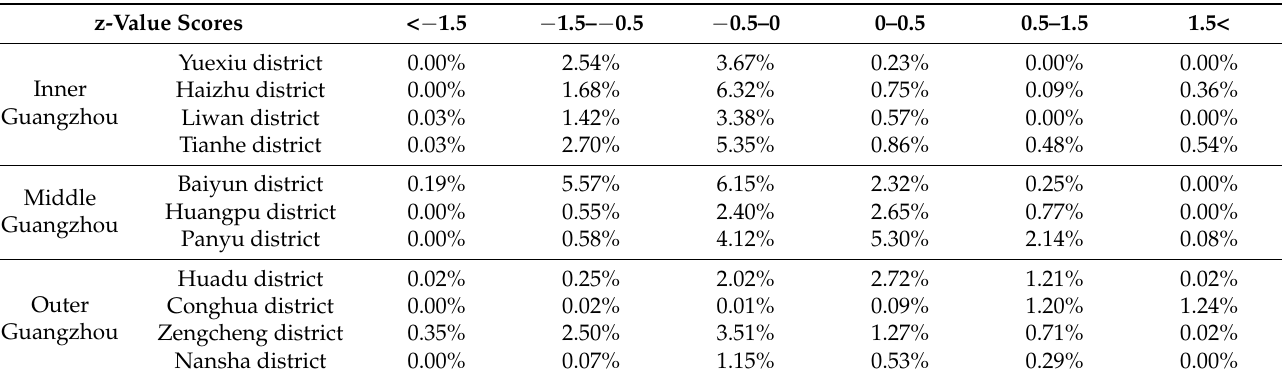
Figure 7. Normalized values of relative ( a ) and absolute ( b ) improvements in time-based accessibility. Table 4. The absolute improvements in time-based accessibility by population according to districts after rail transit lines were